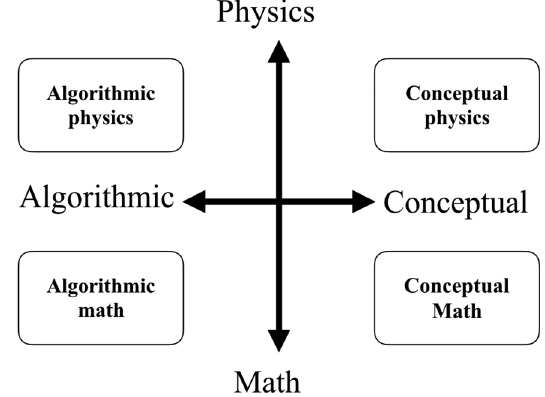
FIG. 1. Math-physics-algorithmic-conceptual theoretical framework. The horizontal axis indicates the algorithmic and conceptual directions. The vertical axis represents the math versus physics directions. Each quadrant is